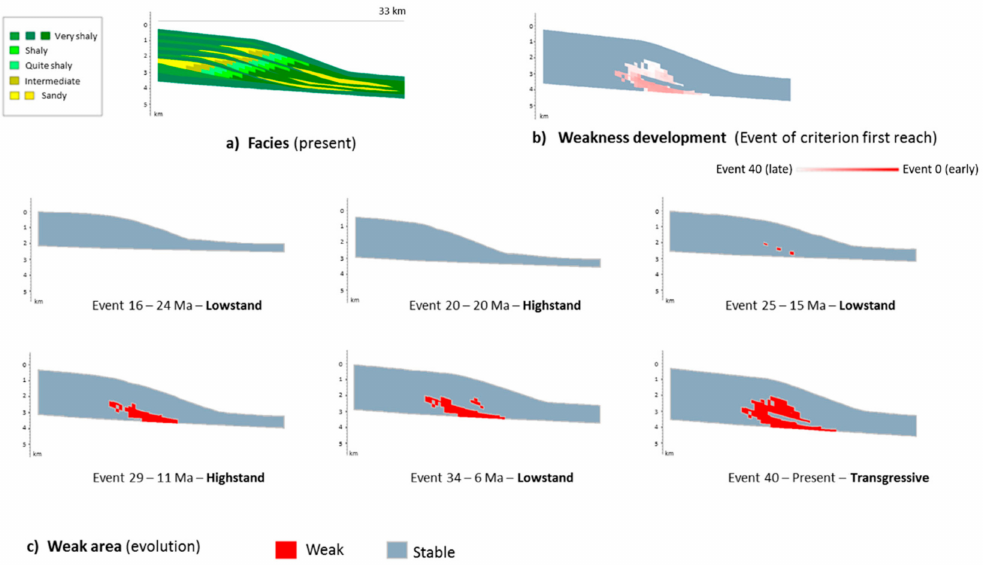
Figure 6. Weakness area simulated on the base case scenario. ( a ) reminder of the lithological facies distribution; ( b ) event of criterion first reach: the stronger the red color, the earlier the area becomes weak; ( c ) overview of the weakness expansion through time from six geological events; vertical exaggeration ×